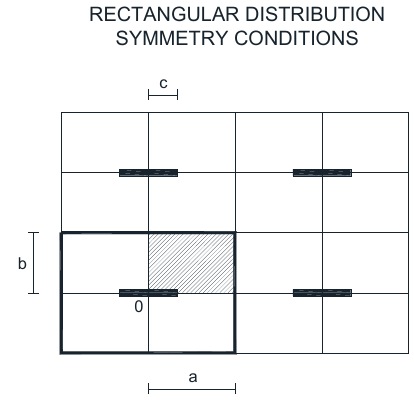
Figure 2. Symmetry conditions of the rectangular layout.